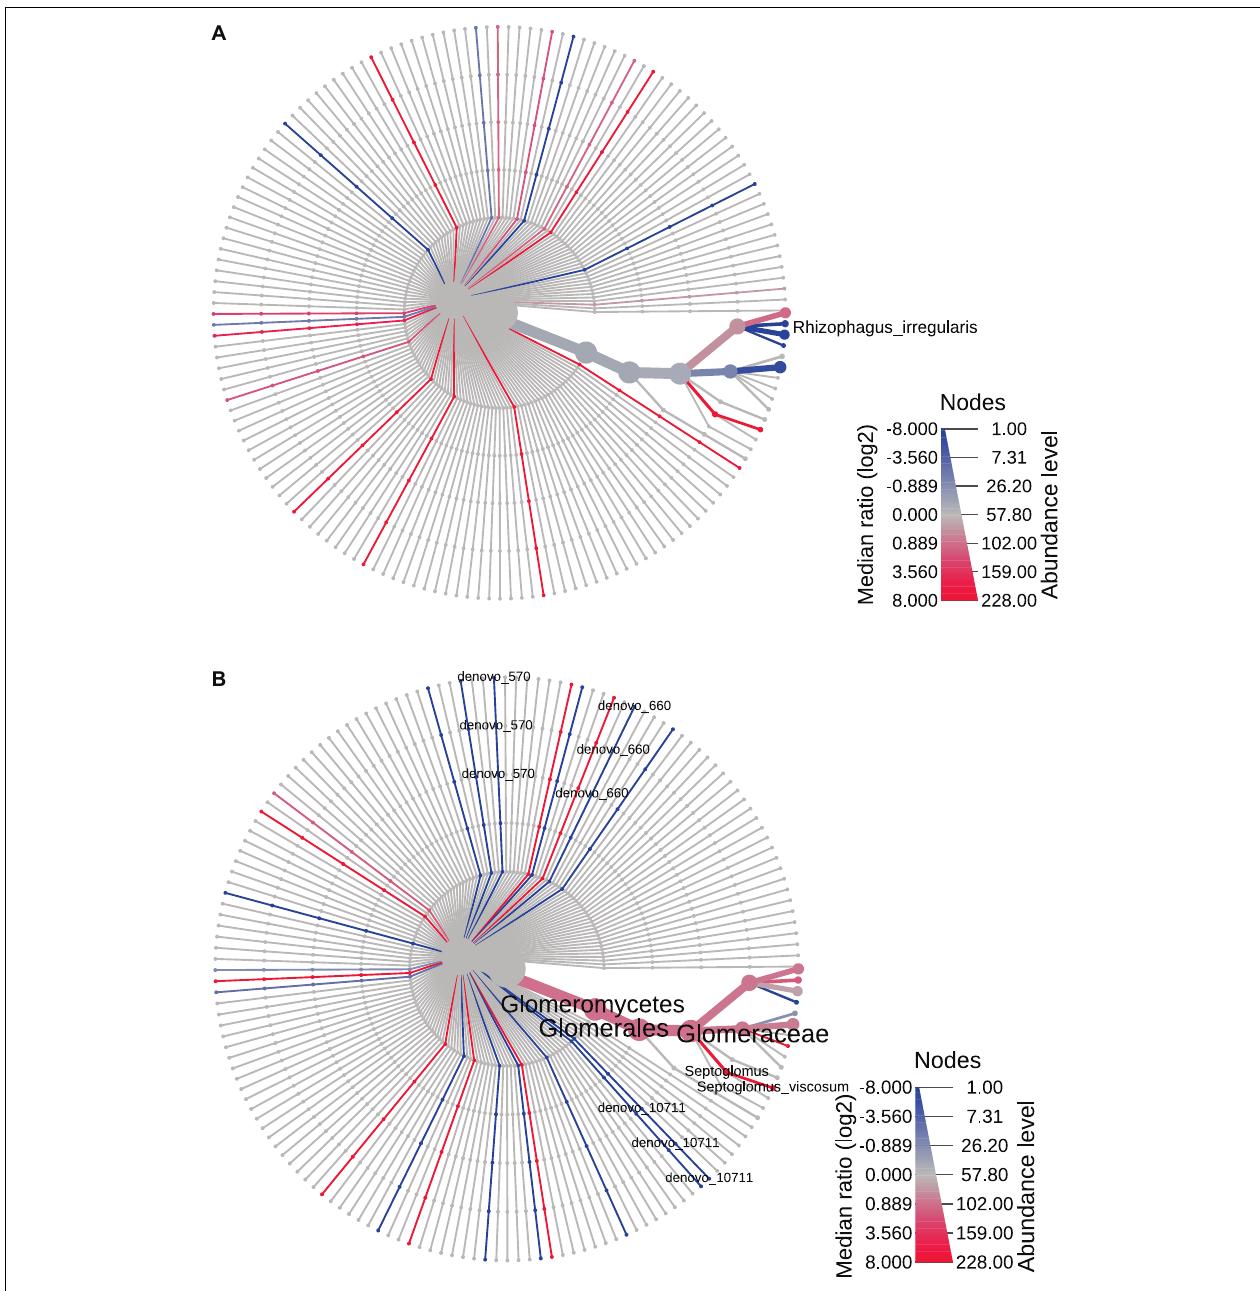
FIGURE 4 | Heat tree based on the factor “time”, reporting the effect of sampling time on the hierarchical structure of taxonomic classifications (median abundance, non-parametric Wilcoxon rank–sum test). (A) Bs1S vs. Bs2S. (B) Rs1S vs. Rs2S. Heat tree analysis was performed using the R metacoder package of MicrobiomeAnalyst, a free available on-line software